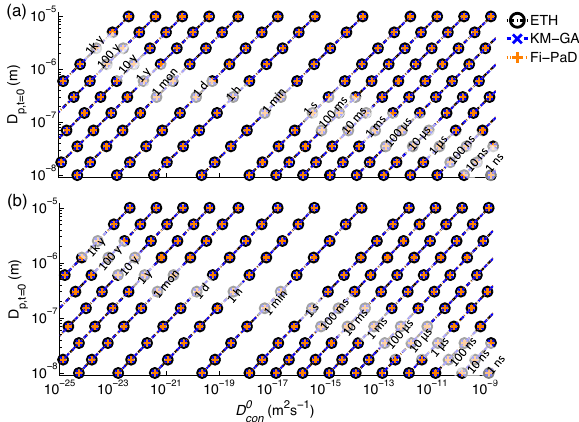
Figure A3. e -folding times (isolines) for the three models given in the legend. Where D 0 con is the constant diffusion coefficient used throughout the simulation. D p ,t = 0 is the initial particle diameter. In (a) the saturation ratio of the semi-volatile is increased from 1 to 90% instantaneously, whilst in (b) it is decreased from 90 to 1%